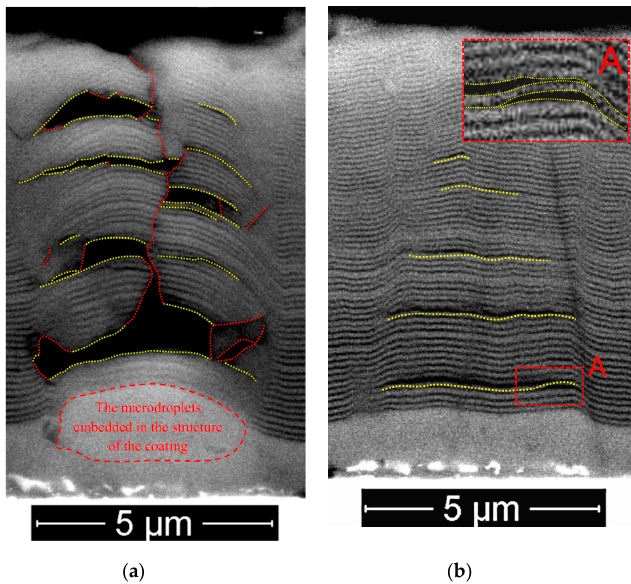
Figure 6. Mechanism of wear and failure. ( a ) The formation of delamination and a transverse crack under the influence of micro-drops embedded in the coating structure. ( b ) The formation of delamination only in the region without internal defects.